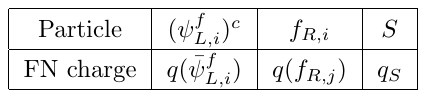
Table 2 . The FN charges of fermions and the scalar